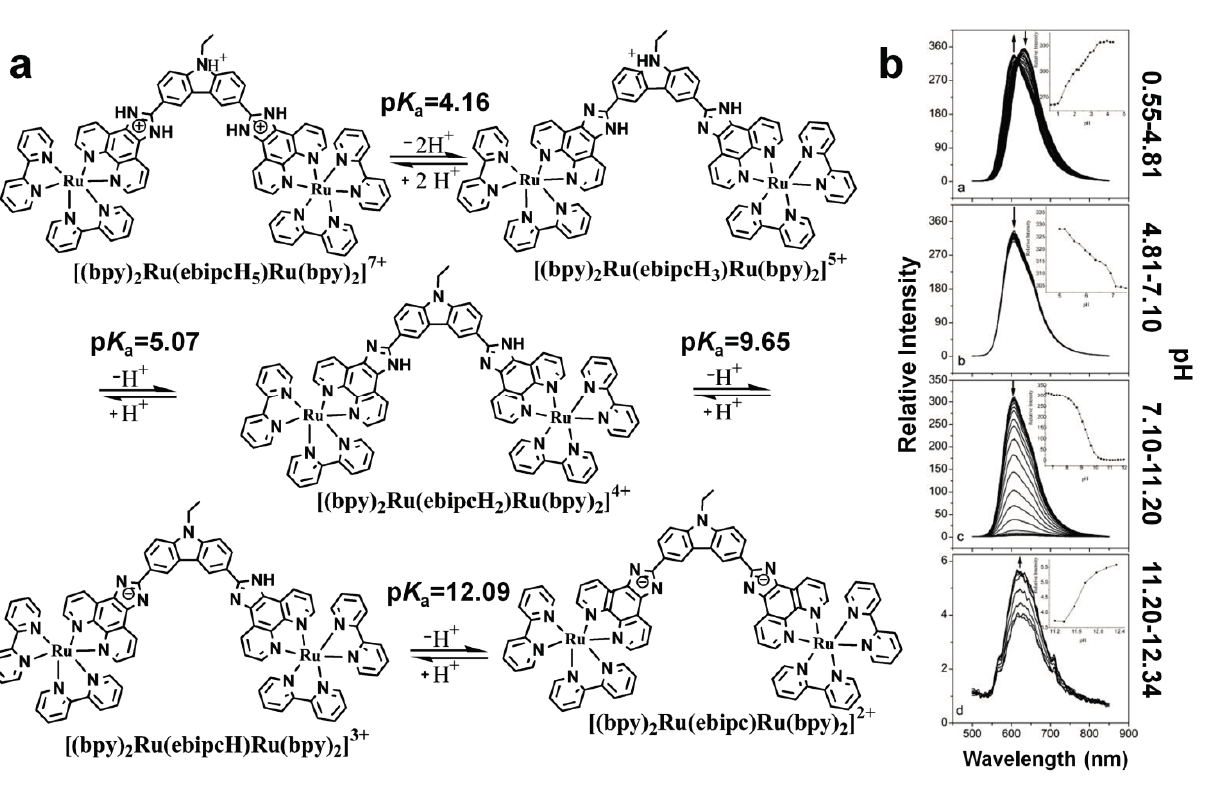
Figure 25. pH effect on “light switch” of [(bpy) Ru(ebipcH )Ru(bpy) ] 4+ . ( a ) the acid-base 2 2 2 Ru(ebipcH )Ru(bpy) ] 4+ ; ( b ) the changes of emission spectra of equilibria of [(bpy) 2 2 2 [(bpy) Ru(ebipcH )Ru(bpy) ] 4+ upon raising the pH. Reprinted with permission from 2 2 2 ref. [238], copyright (2004) American Chemical